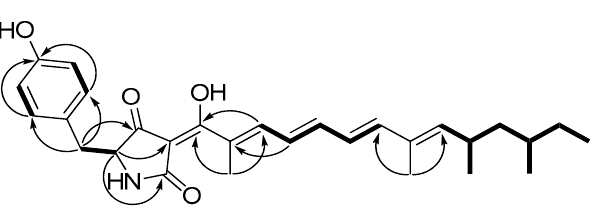
Figure 1. Structures of compounds 1 – 6 .